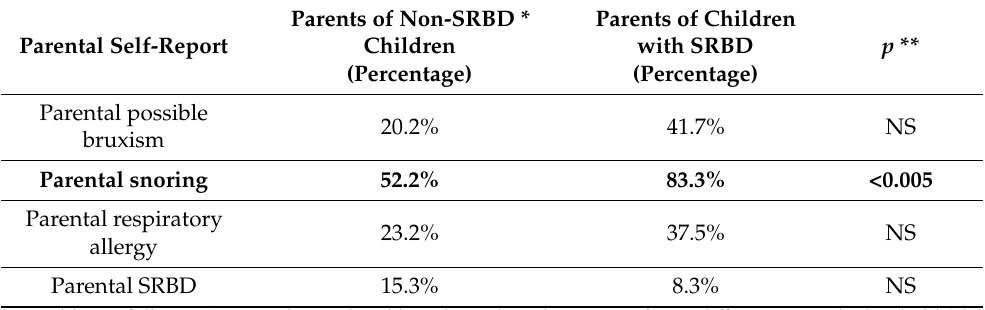
Table 4. Parental self-report.